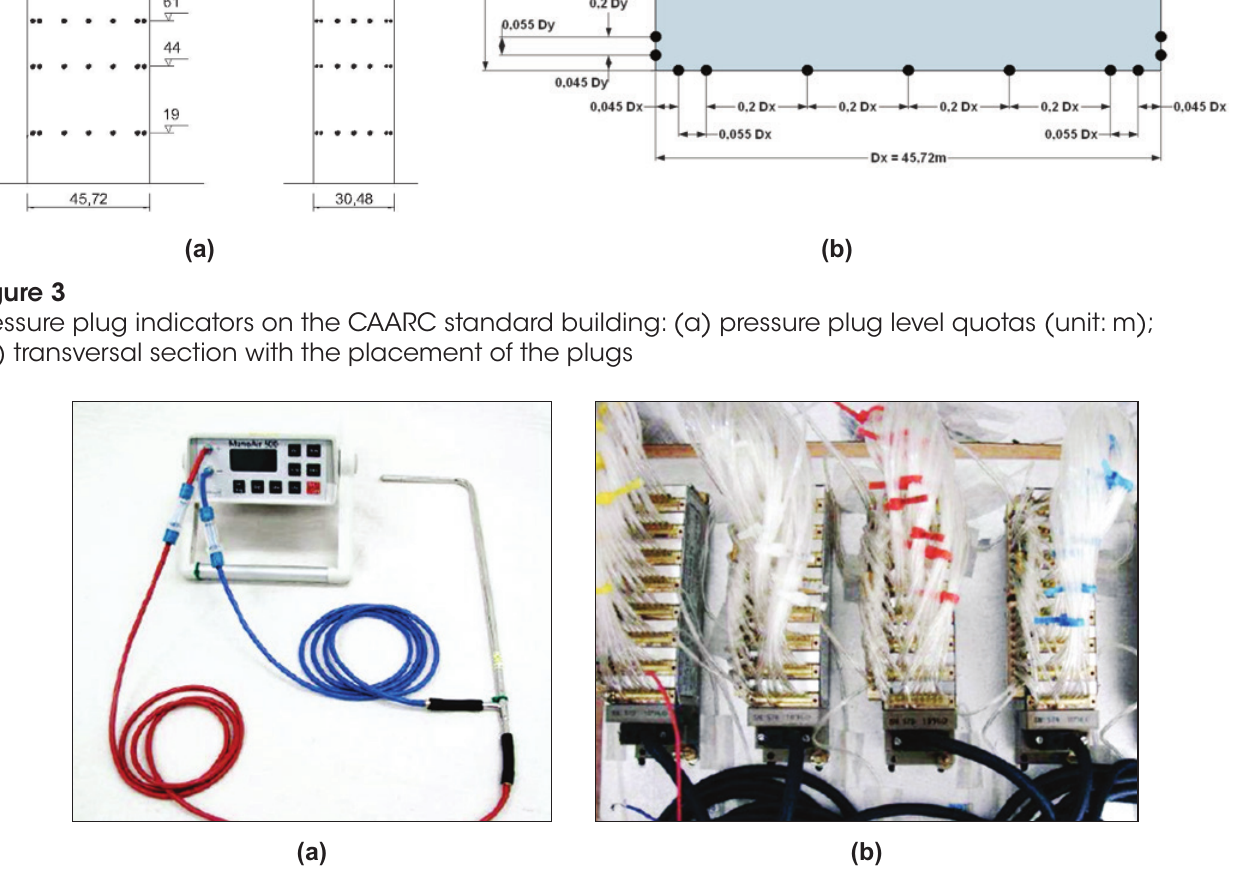
Data reading equipment: MANOAIR and connection tubes to the piezometric rings of the wind tunnel; (b) Scanivalve with the 64 pressure measuring channels by